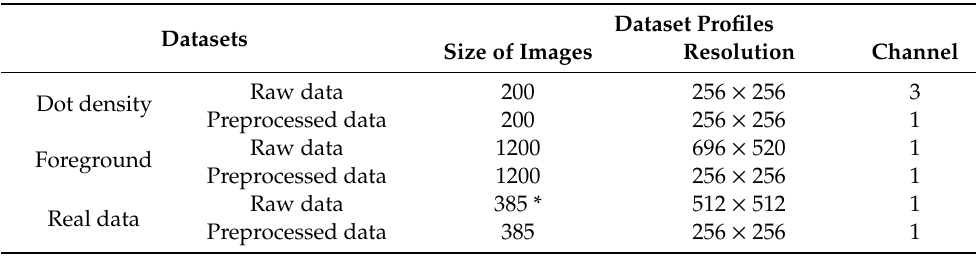
Table 1. The two synthetic